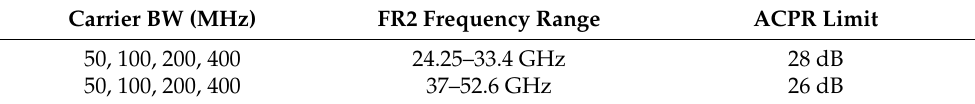
Table 2. ACPR requirements for 3GPP NR carrier